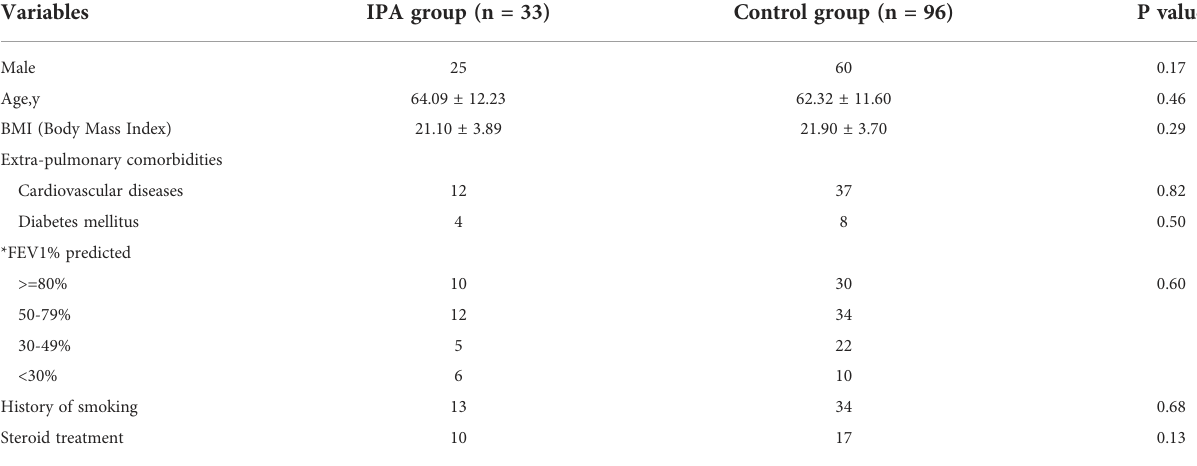
TABLE 1 Demographic characteristics of the study